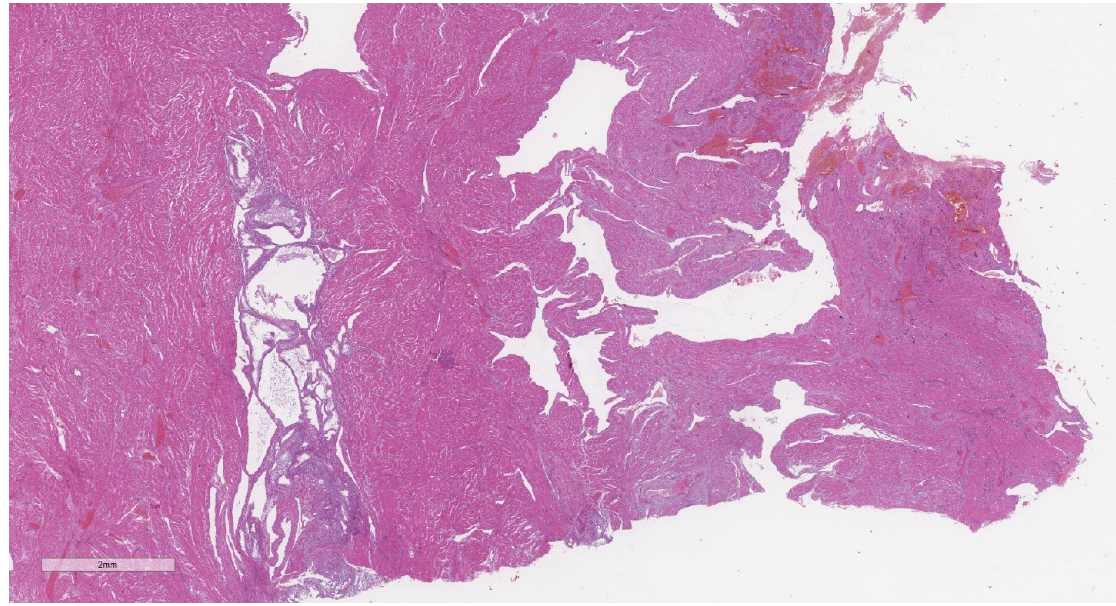
Figure 3. Representative microphotograph of a post-partum uterus with adenomyosis. Hematoxilin and eosin (H&E), 1×. At low-power magnification, the placental implant is evident on the right, and with the underlying adenomyosis on the left.